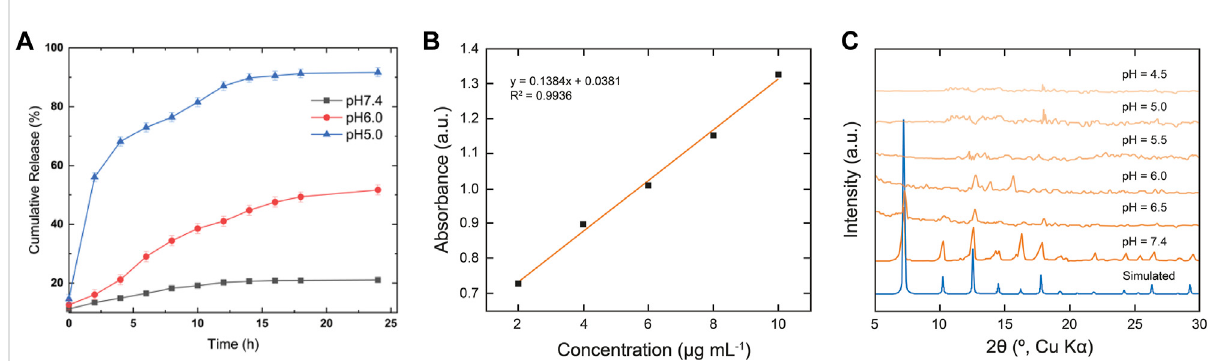
FIGURE 3 (A) Invitro cumulativereleaseofCis fromRGD@Cis ⊂ nZIF-90inPBSatpH=7.4(black squares), 6.0(redcircles),and5.0(blue triangles)for 24 h at37 ° C (B) CalibrationcurveofCisat302 nm. (C) PXRDdatacomparingthesimulatedpatternofnZIF-90toexperimentalnZIF-90samplesimmersed in different pH